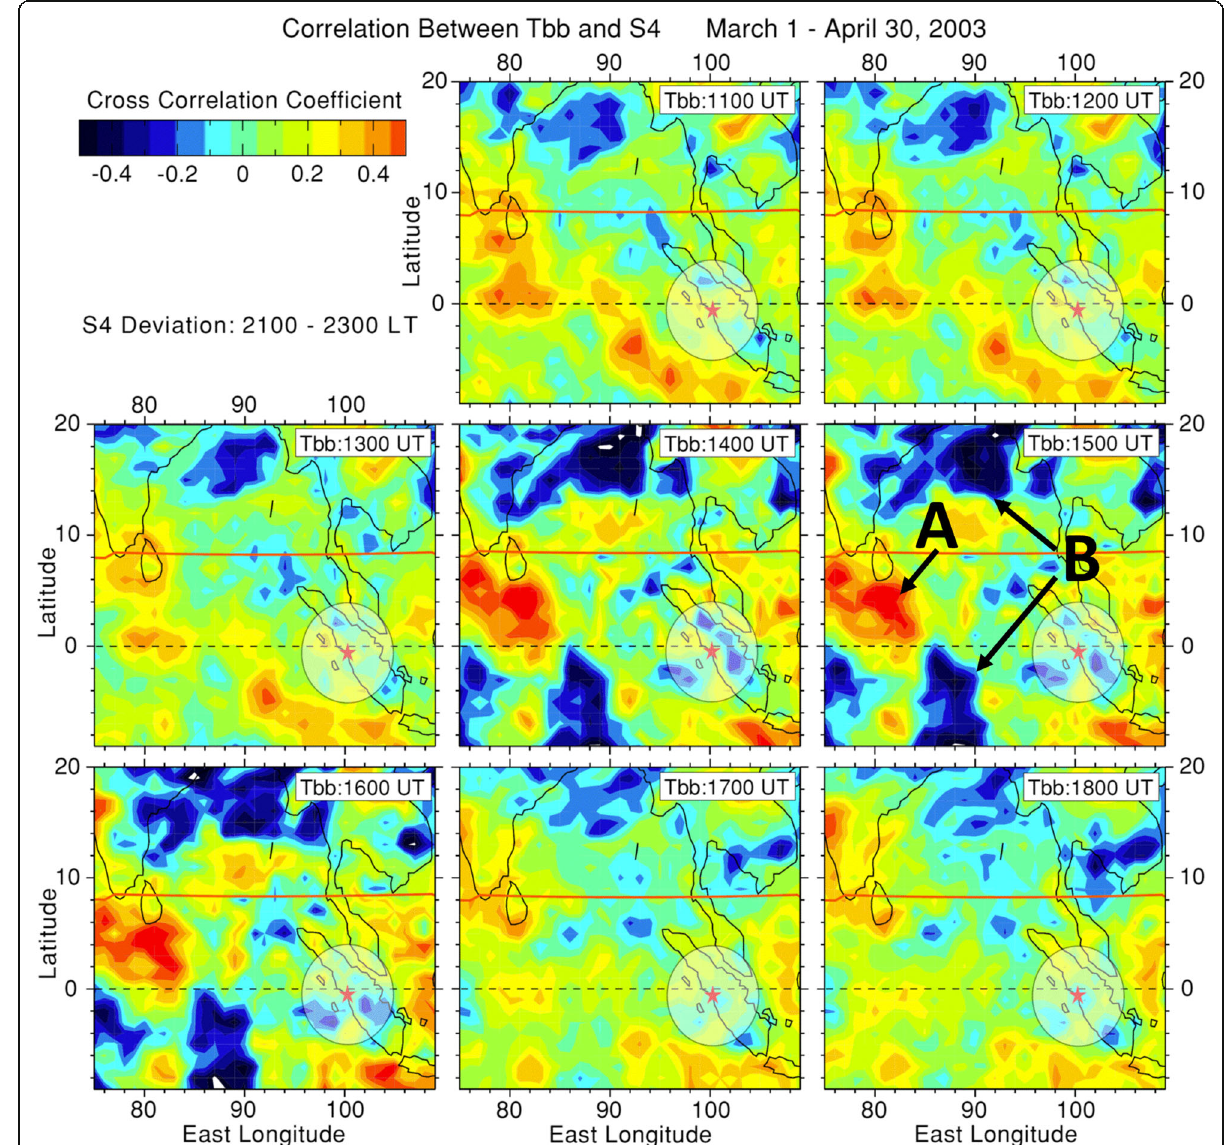
Fig. 1 Cross-correlation between day-to-day variability of OLR cloud-top temperature T bb and GPS scintillation index S 4 observed at Kototabang (0.2 S, 100.8 E). This figure is taken from Fig. 3 of Ogawa et al. (2009). The observation period is March and April 2003. The red star ( ★ ) indicates the location of Kototabang, where GPS scintillation measurements were performed. The circle around the red star shows the relevant area of S 4 . T bb data are taken hourly, and the correlation is obtained for each hour. Local time at Kototabang is 7 h ahead of UT. “ A ” and “ B ” indicate high positive and negative enhancement of correlation coefficients,